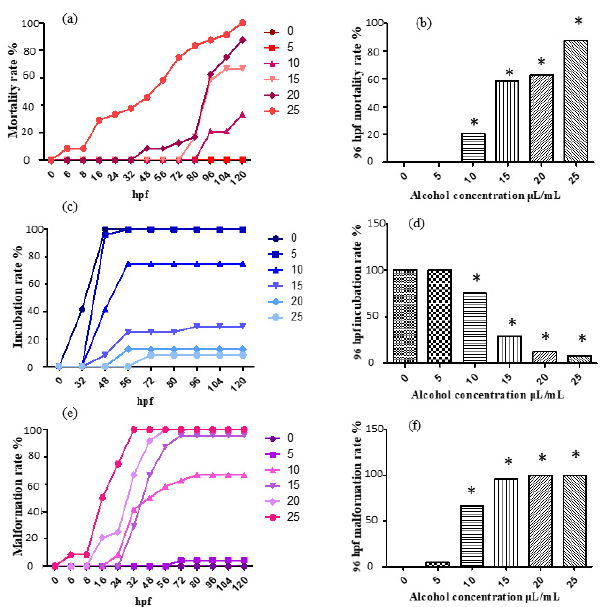
Figure 1. The mortality rate, incubation rate and malformation rate after ethanol treatment. The results were analyzed by χ 2 test, vs. the control group (0 μ L/mL ethanol): * p < 0.05. ( a ) mortality rate; ( b ) mortality rate at 96 hpf; ( c ) incubation rate; ( d ) incubation rate at 96 hpf; ( e ) malformation rate; ( f ) malformation rate at 96 hpf.